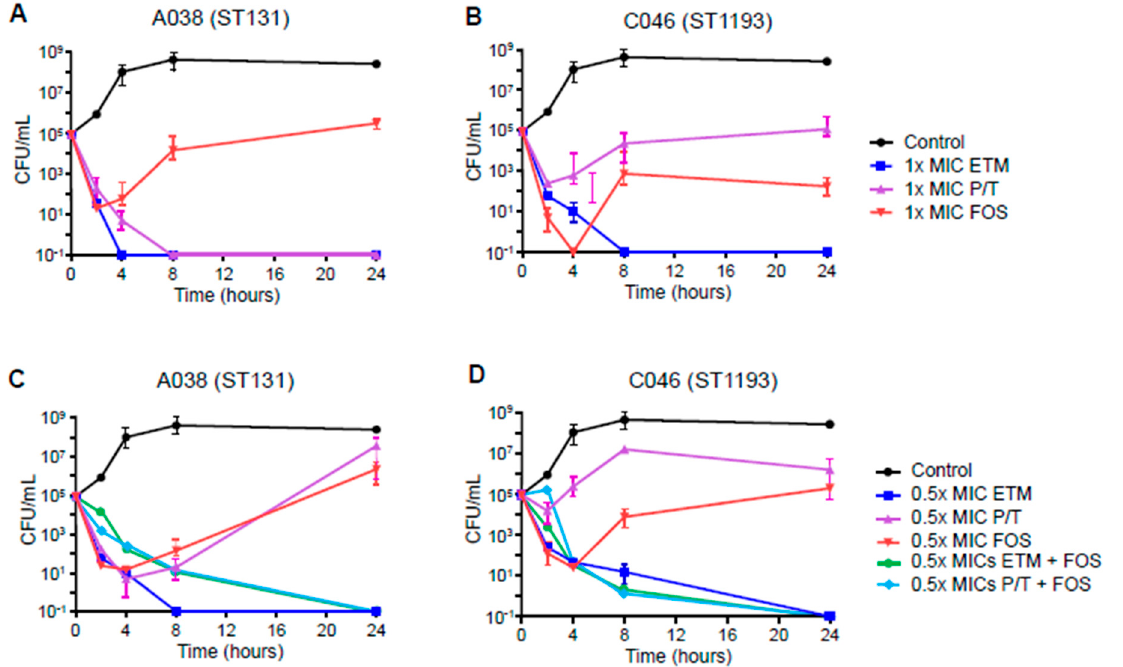
Figure 2. Time-kill curves for ertapenem, piperacillin-tazobactam, and fosfomycin against ESBL-producing E. coli isolates, CTX-M-15-producing A038 (ST131) and CTX-M-14-producing C046 (ST1193). ( A and B ), the results of 1 × MICs of single antibiotics, ( C and D ), the results of 0.5 × MICs of single and combination of antibiotics. ETM, ertapenem; P / T, piperacillin-tazobactam; FOS, fosfomycin.